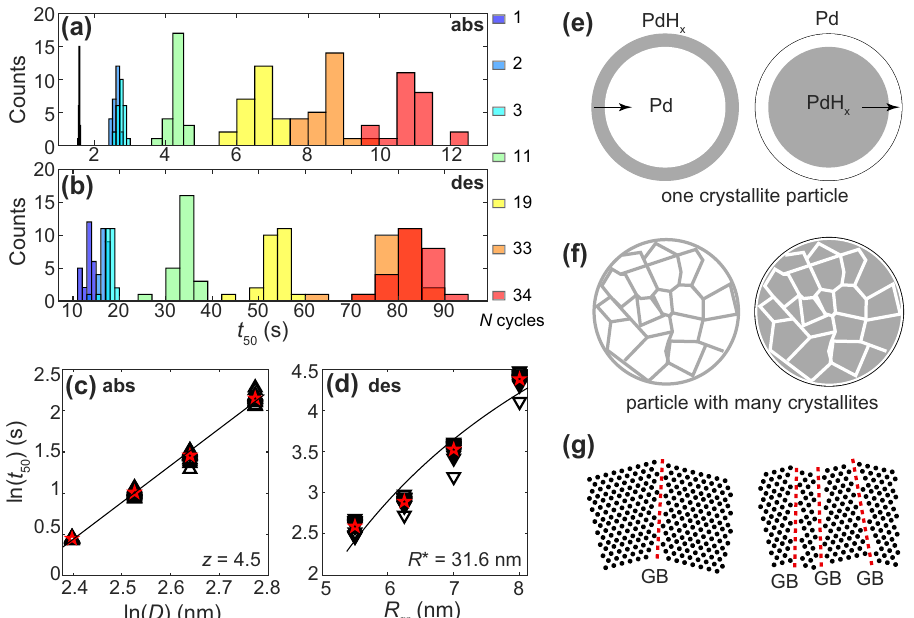
Fig. 4 Grain growth in fl uence on t 50 and schematics of (de)hydrogenation process. a Distribution of t 50 values corresponding to absorption and b desorption for N (color code) (de)hydrogenation cycles measured at 303 K. Note the dramatic deceleration of the sorption kinetics and widening of the t 50 distribution upon cycling. c Power-law scaling of t 50 and crystallite diameter ( D ) of 24 individual Pd particles. The linear fi t corresponds to z = 4.5 according to Eq. 3. d ln( t 50 ) as a function of grain radius ( R gr ) for dehydriding. The solid line represents the best fi t according to Eq. 4, resulting in the corresponding parameter R* = 31.6 nm. Red stars in c and d represent the average value for 24 individual particle data (upward and downward pointing triangles, respectively). Slowing down of the kinetics is observed for all measured temperatures for both absorption and desorption (Supplementary Fig. 12). e Schematics of hydride formation (left) and decomposition (right) for a particle consisting of a single crystallite and f a particle containing many crystallites. The arrows show the direction of the (de)hydrogenation process (inward or outward). Gray and white areas depict the hydride and metal state, respectively. g Schematics of the atomic structure at the surface of a particle for the case with few (left) and many (right) grain boundaries (GB) indicated by red dashed lines, where the presence of many GBs leads to an atomically rougher surface with more low-coordinated